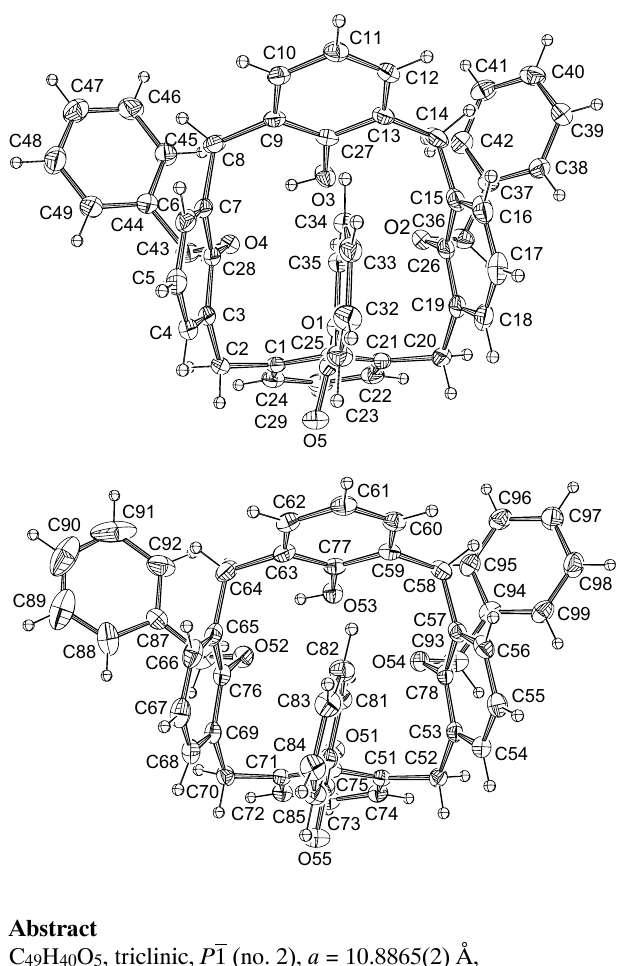
Source of material